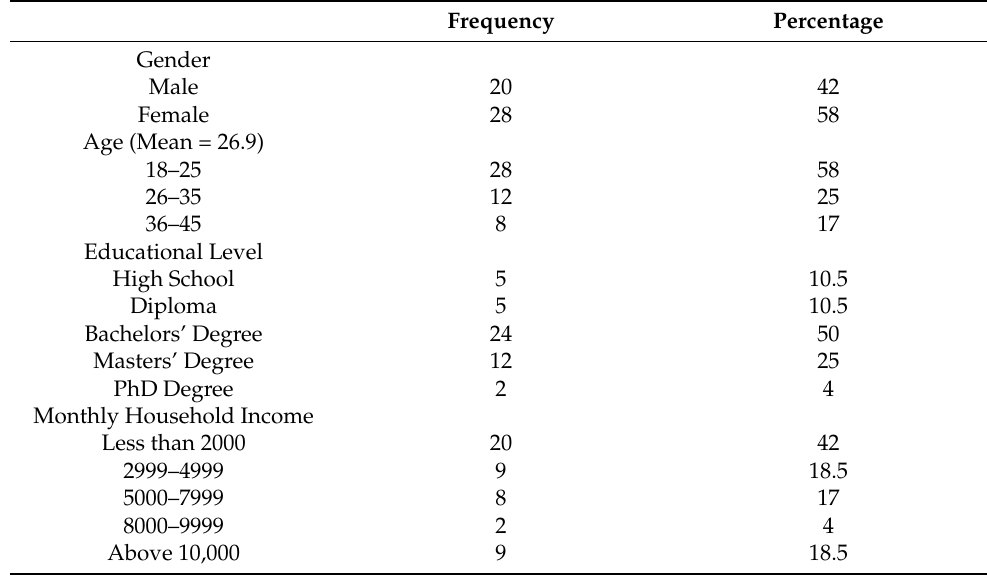
Table 2. Demographic information of the